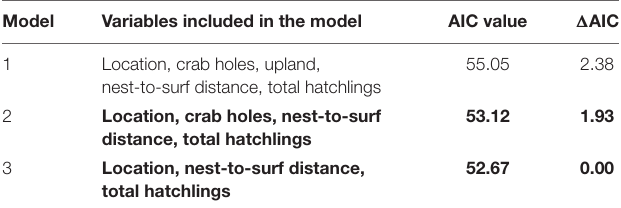
TABLE A1 | Supplementary Table of GLM results using all possible predictor